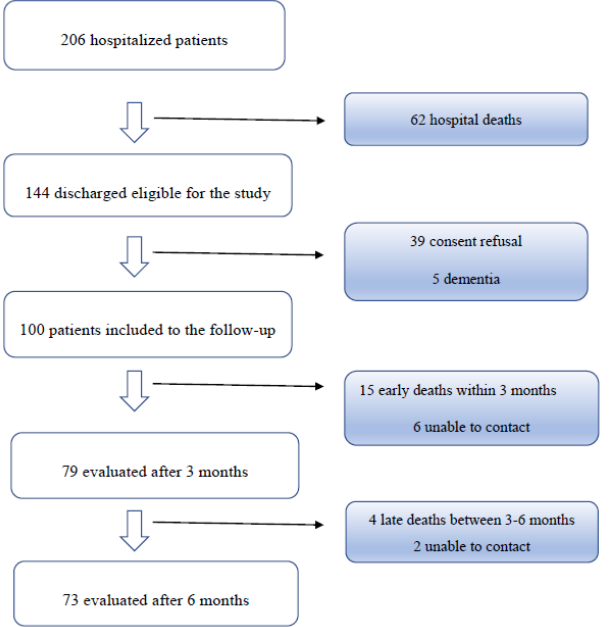
Figure 1. Flow chart of HD patients with COVID-19 admitted to the 7th Navy Hospital between